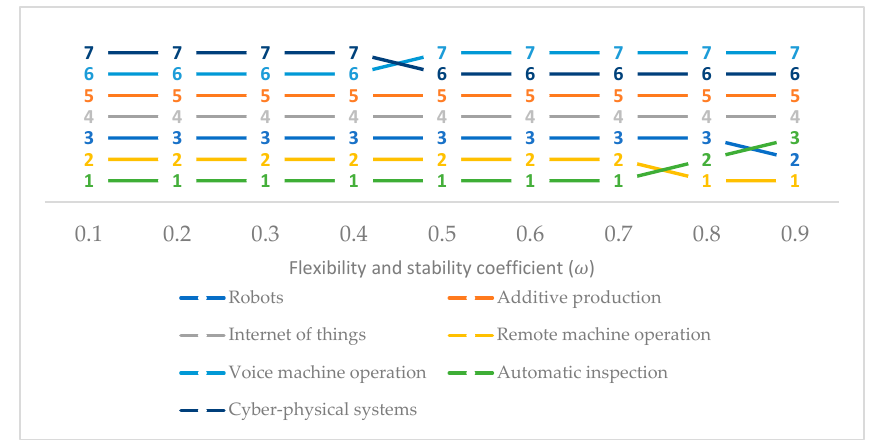
Figure 6. Stability coefficient sensitivity analysis results.